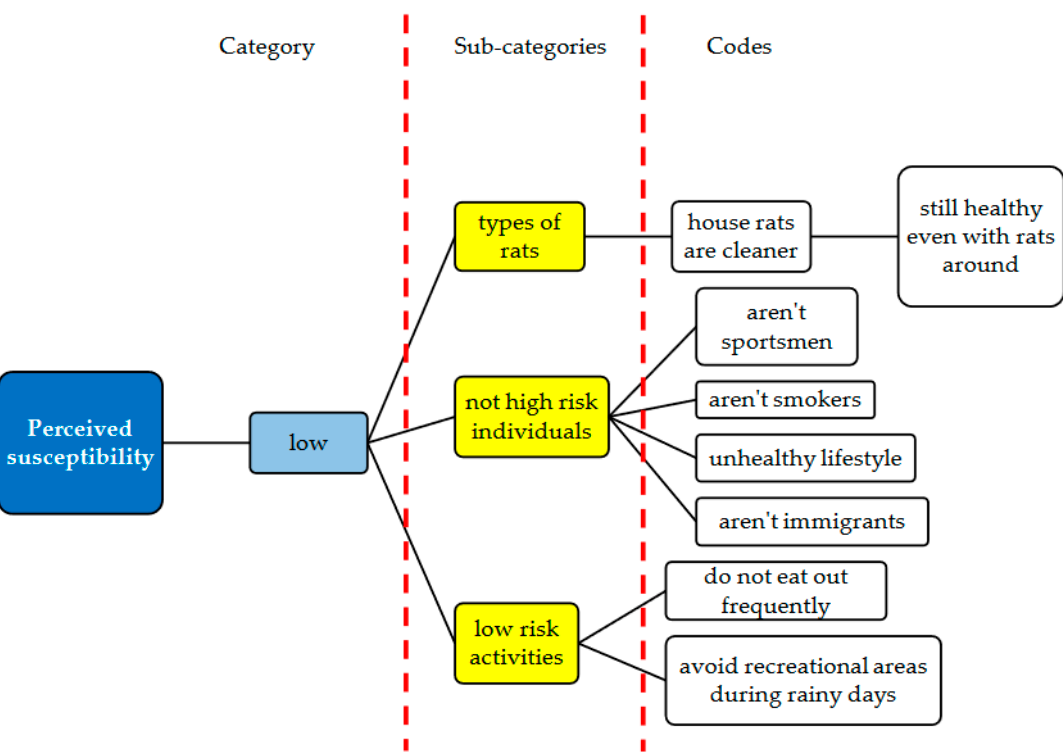
Figure 2. Mapping of the category, sub-categories and codes pertaining to the perceived susceptibility of leptospirosis infection.